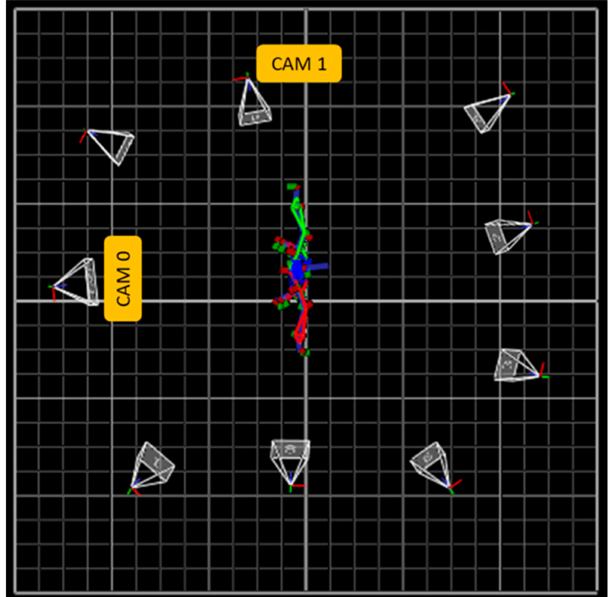
Figure 4. Experimental camera layout for RGB (those labeled in yellow) and Vicon system.